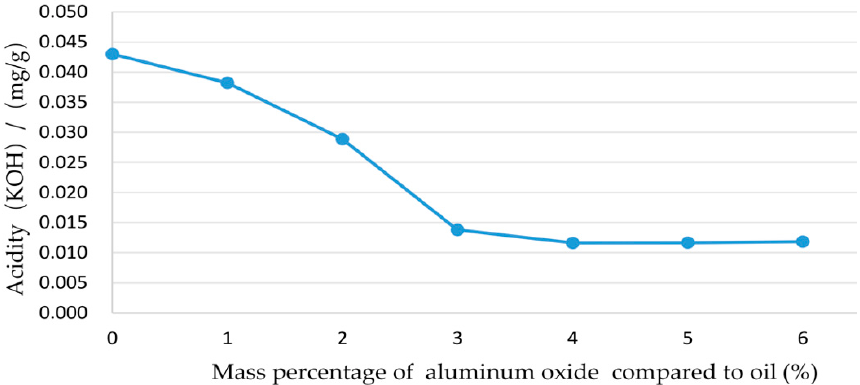
Figure 6. The effect of alkaline aluminum oxide treatment on the acid value of Jatropha curcas seed oil. Seed oils had been previously treated with KOH (1%, w/w) and active clay (10%, w/w).